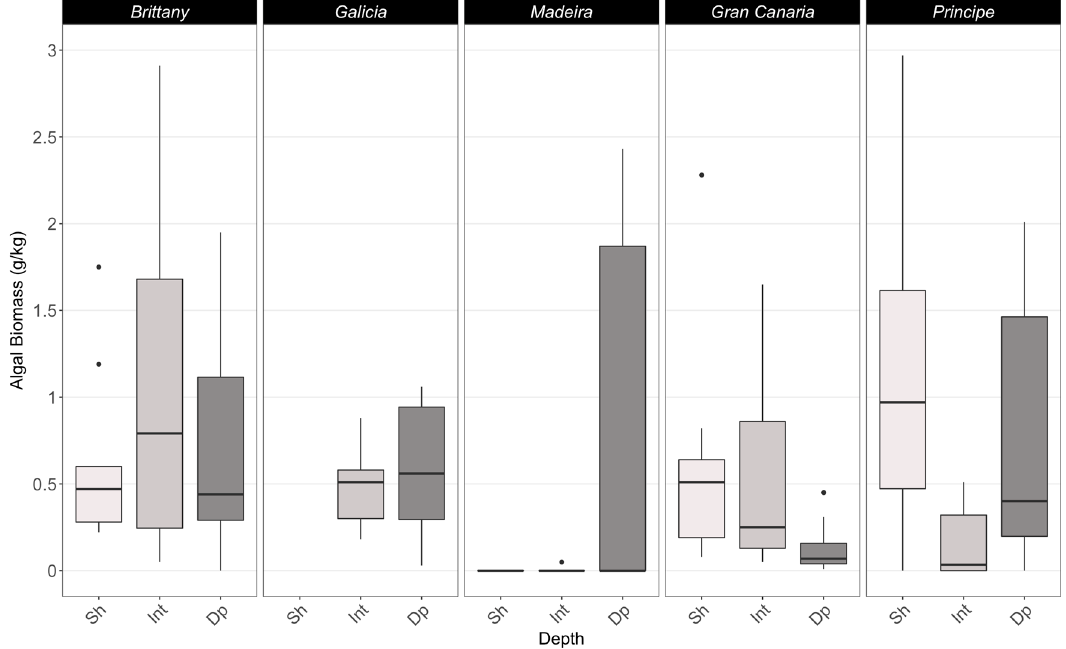
Figure 5. Total epiphytic macroalgal biomasses (dry weight) at each depth strata (Sh: Shallow; Int: Intermediate and Dp: Deep) and regions. Data pooled for the two locations within each region.